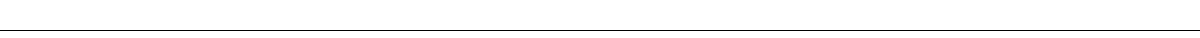
NATURE COMMUNICATIONS|8:15463|DOI: